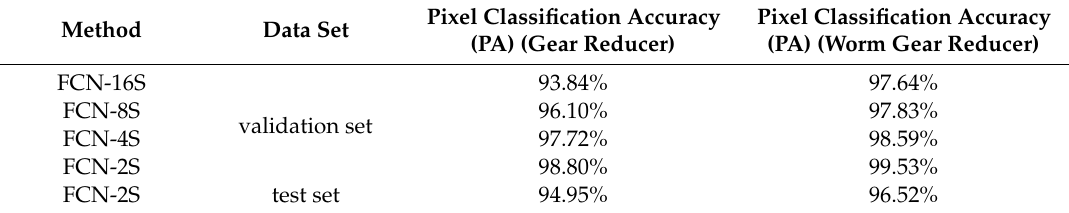
Table 4. Comparison of pixel classification accuracy.